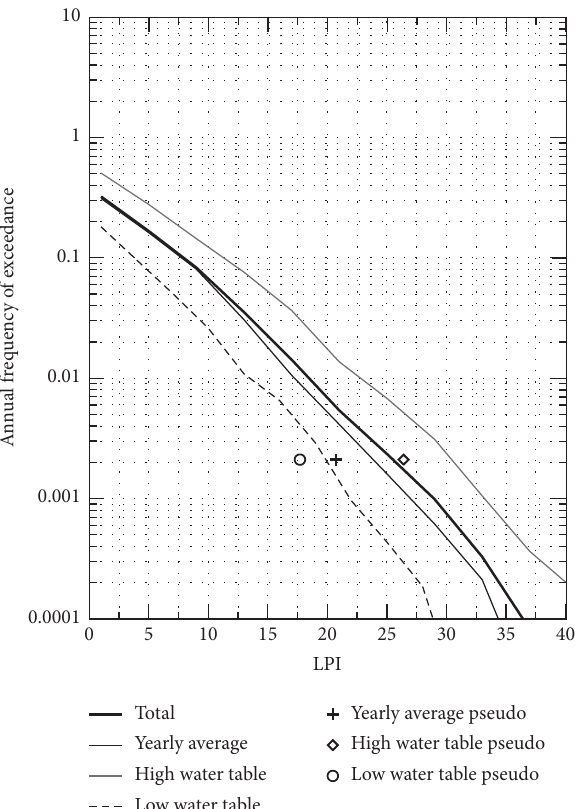
Figure 6: Total and unweighted LPI hazard curves from different water table levels of BH-S1.